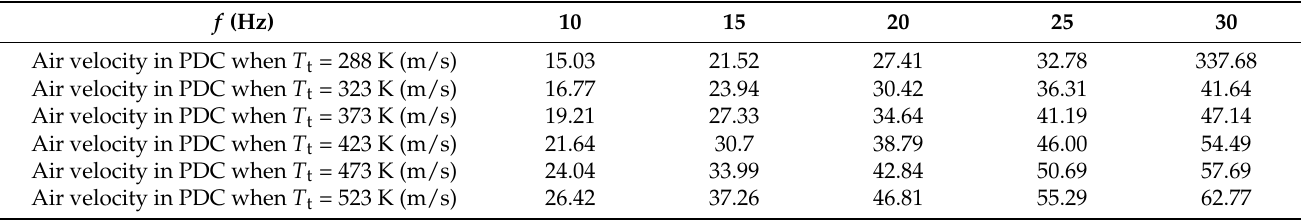
Table 2. Air velocity in PDC at different working